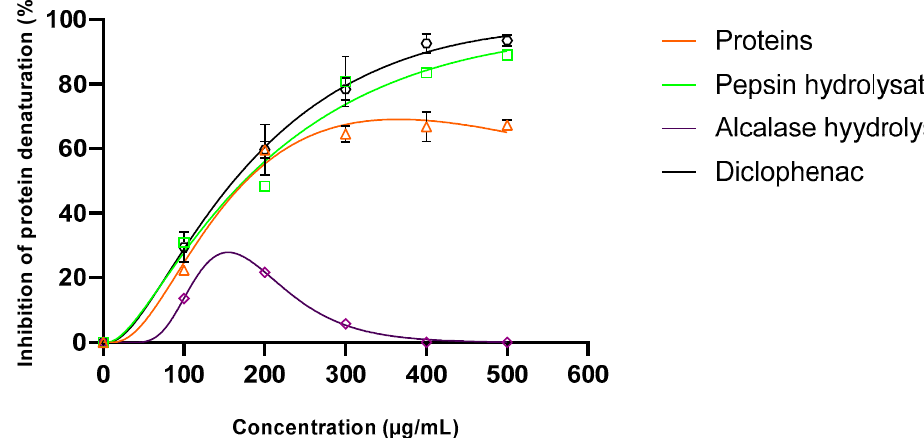
Figure 5. Inhibition of albumin denaturation by crude protein extract and peptides at different con- centrations .